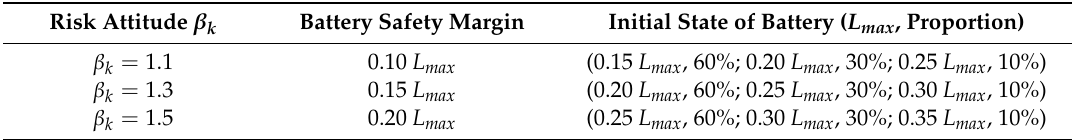
Table 3. Battery safety margin and the initial state of battery.